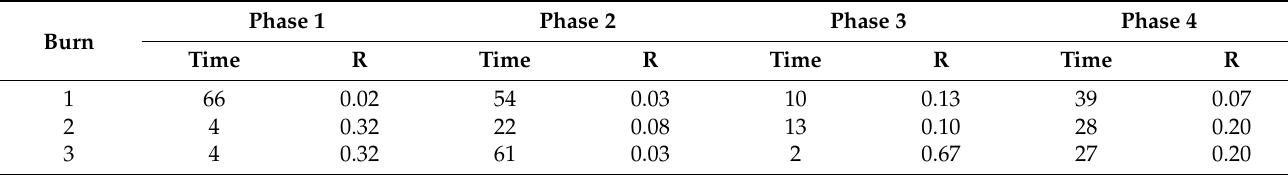
Table 4. Burning time and heating ramps on each phase during carbonization in modified Brazilian beehive kiln.